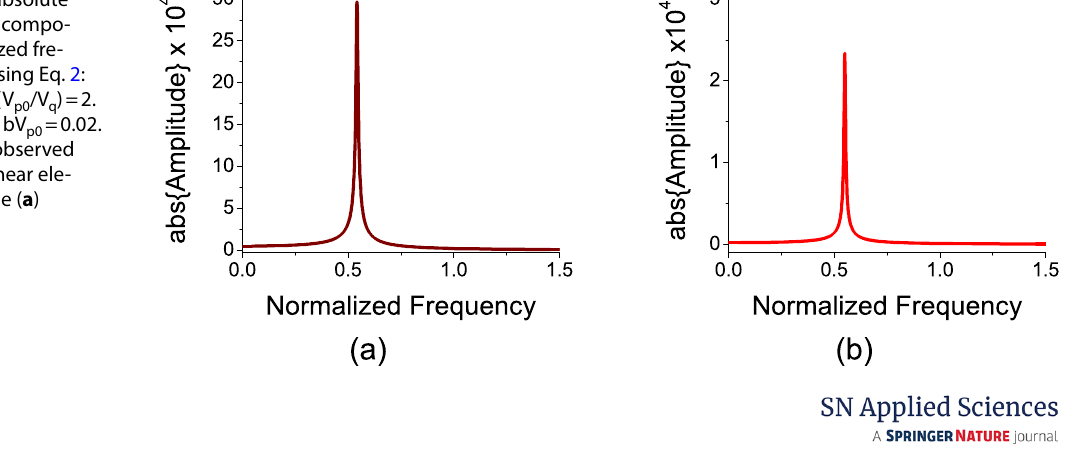
Fig. 2 Models: the absolute value of the Fourier compo- nent vs the normalized fre- quency, f. a When using Eq. 2: (V /R I ) = 0.01 and (V q 0 0 b When using Eq. 3: bV